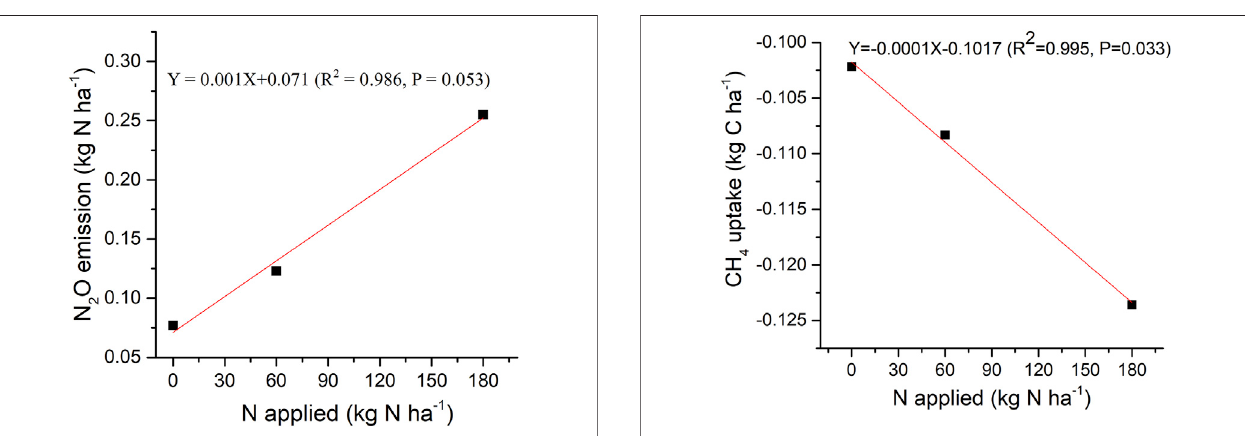
FIGURE 6 | Relationship between the cumulative CH 4 absorption between the sowing and jointing stages and the N